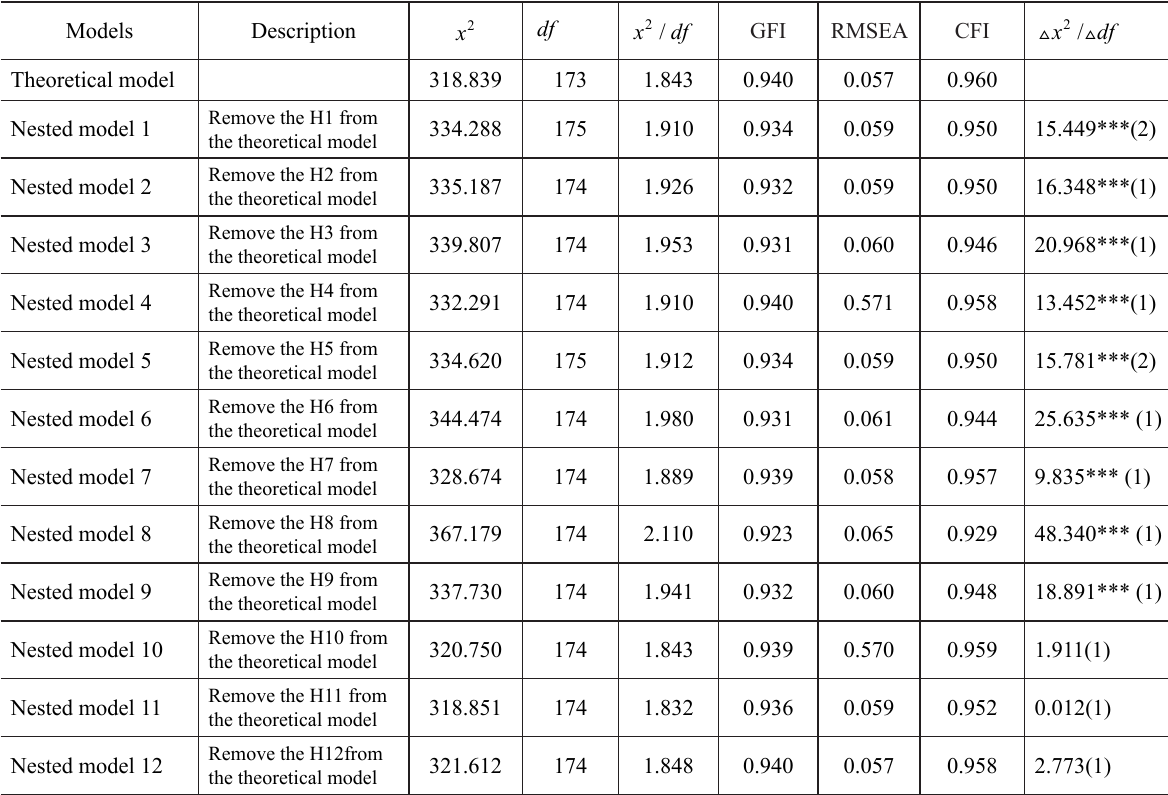
Table 4. Comparative analysis of nested models and theoretical models